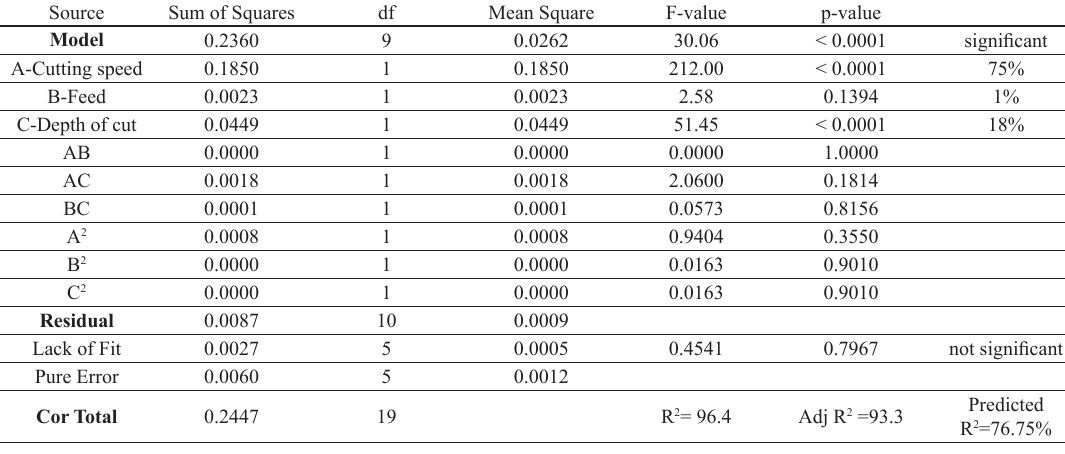
Table 6. ANOVA for prediction of tool wear.